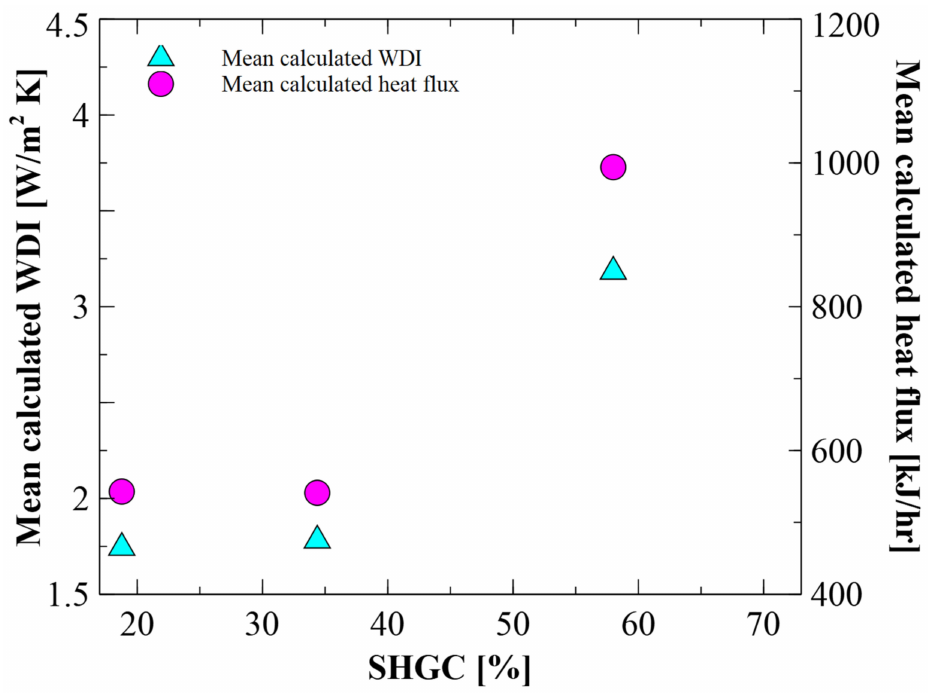
Figure 10. Comparison of mean calculated WDI and